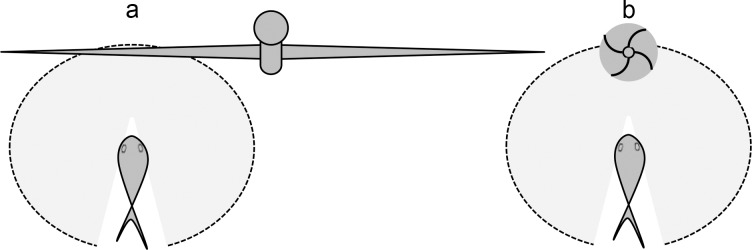
Fish visual coverage of (a) a large diameter turbine, and (b) a small object.In limited visibility a fish may be able identify a small object, like a vertical-axis turbine or a trawl otter board, at approximately the same time as it comes in view. But a very large object, like a horizontal-axis turbine, may never be fully within view and approaching fish cannot be expected to know the shortest path of avoidance. Shaded semi-circles indicate fish fields of view.